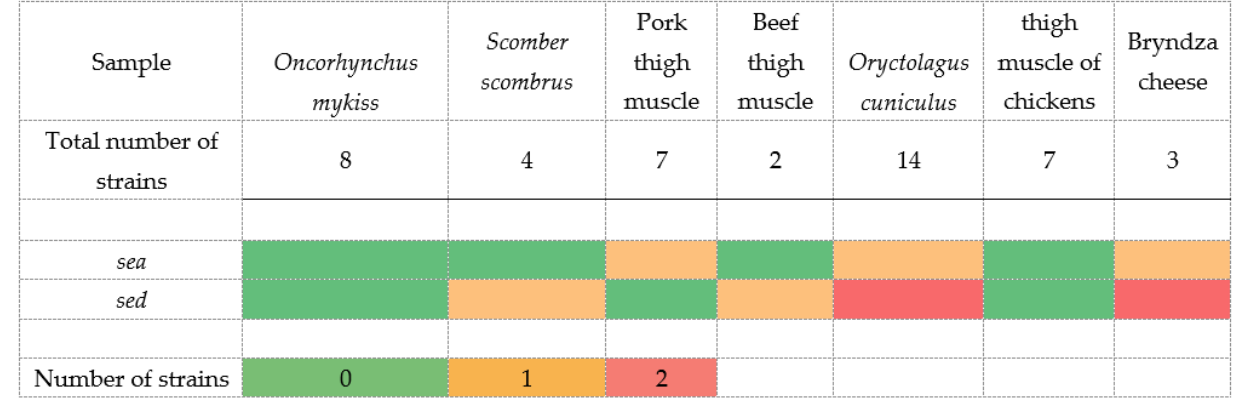
Figure 1. Heatmap demonstration of the presence and absence of genes encoding staphylococcal enterotoxins.